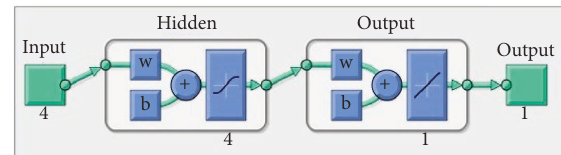
Figure 6: Optimum ANN